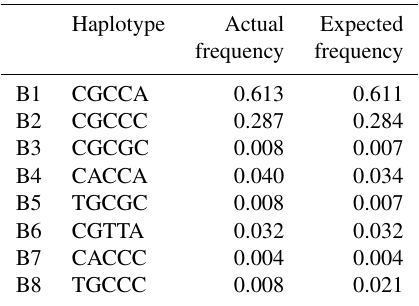
Table 4. Haplotype information of buffalo CSN3